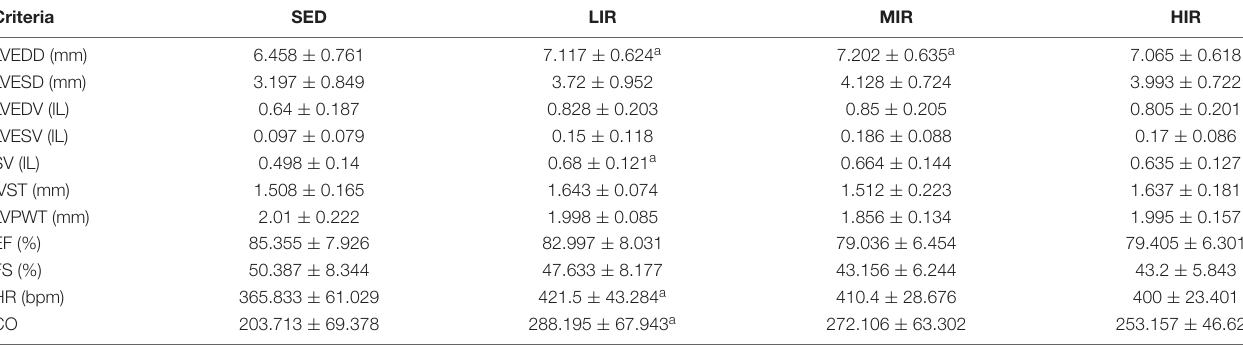
TABLE 4 | Echocardiographic analysis of SD rats subjected to different treadmill running intensities after 8 weeks.